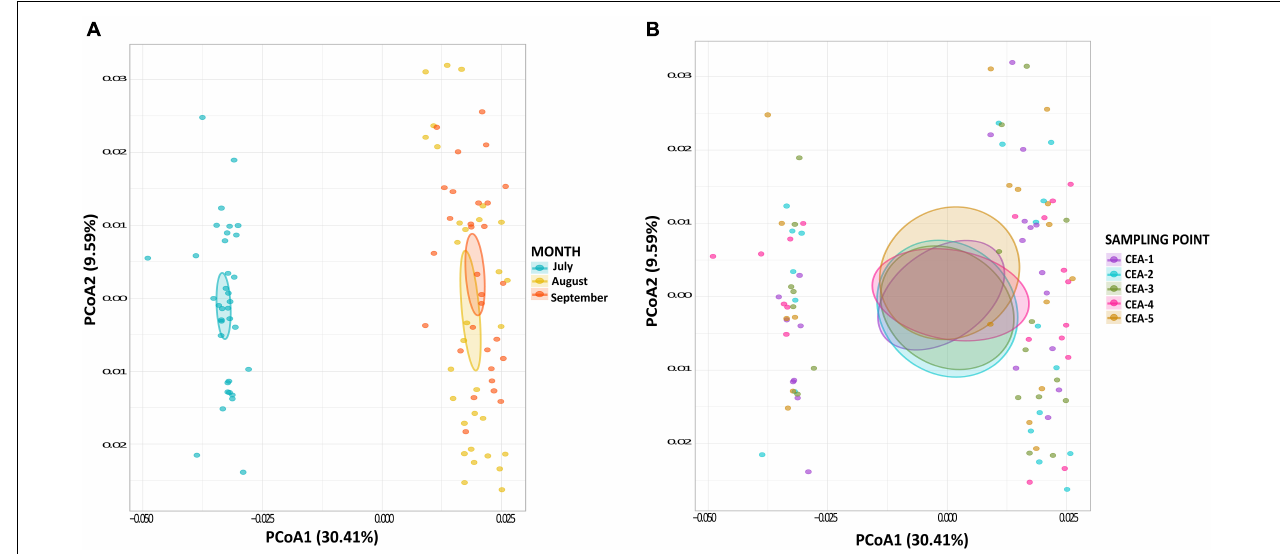
FIGURE 3 | (A) PCoA of potential functions of all biogeochemical cycles by sampling month. (B) PCoA of potential functions of all biogeochemical cycles by sampling site.